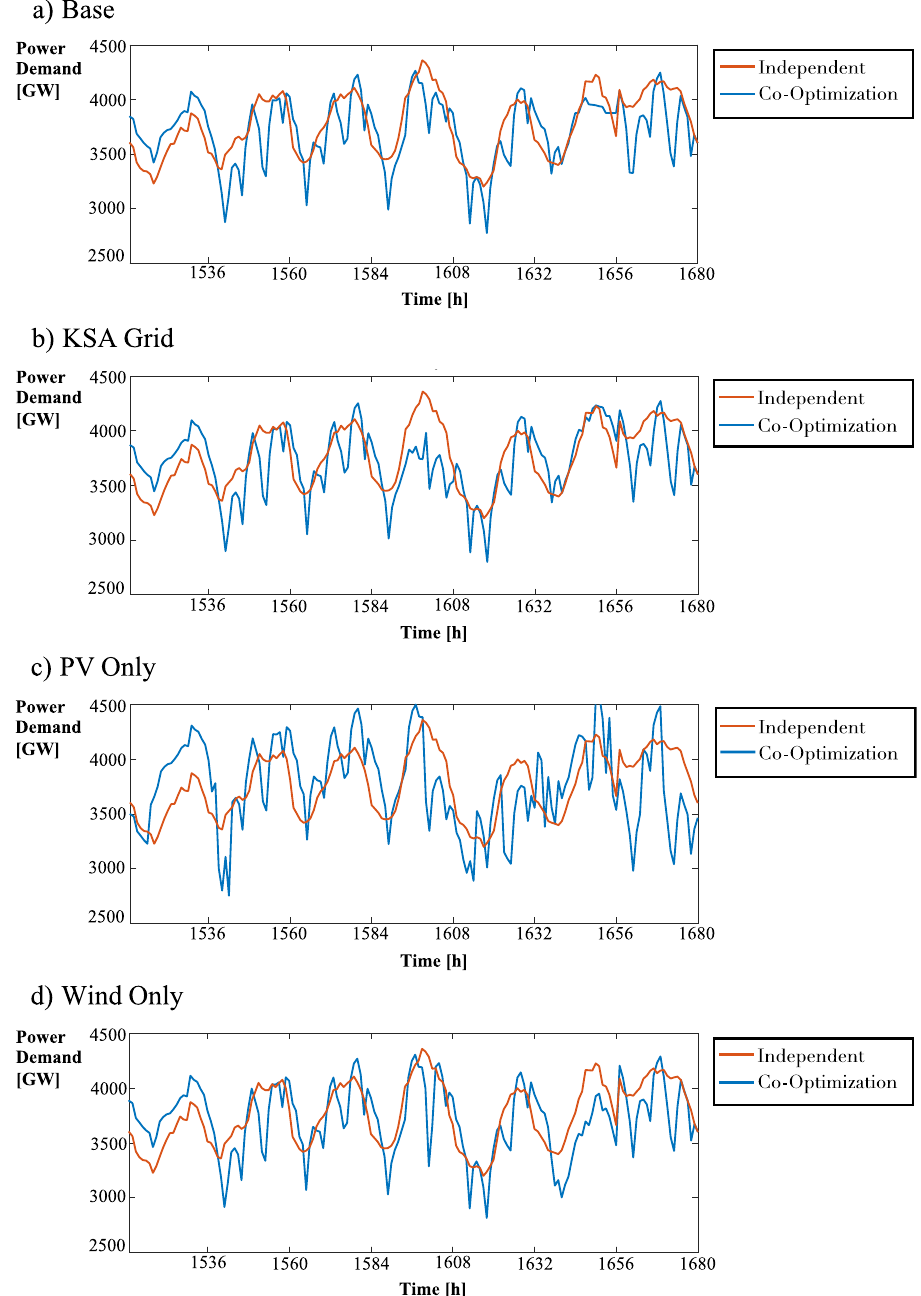
Fig. 5 Power demand for the a) Base, b) the Kingdom of Saudi Arabia (KSA) Grid, c) Photovoltaics (PV) Only, and d) Wind Only cases under independent and co-optimization strategies. Due to co-optimization, peak shavings occur in all cases. Power consumption is shifted accordingly – at the start of the year, the co-optimized model consumes more power than the independent model. However, the co-optimized model consumes less power than the independent model at speci fi c times throughout the remainder of the